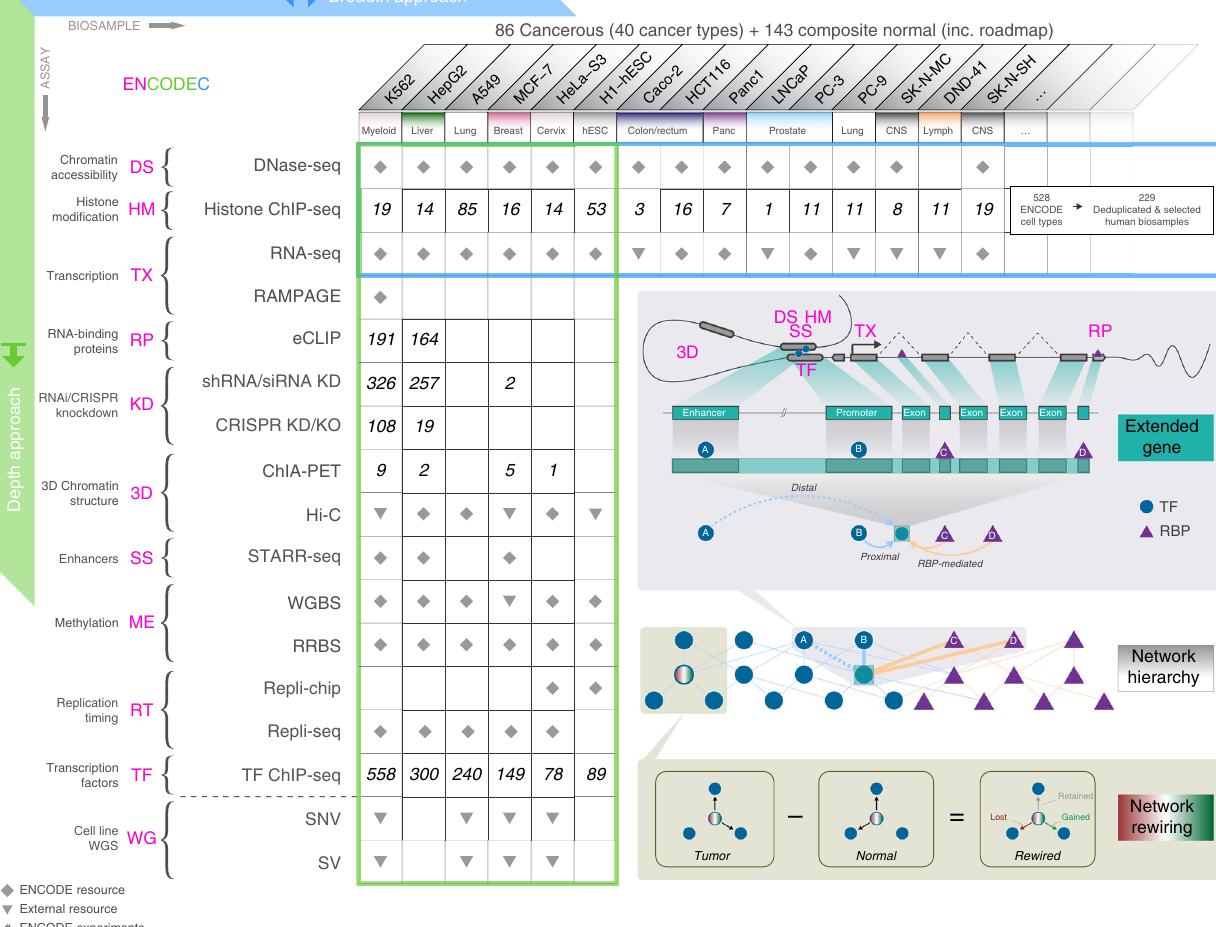
Fig. 1 Overview of the ENCODEC resource. Table columns list cell types and rows list assays. Blue table boundary: Cell types with assays in the ENCODE Encyclopedia highlight the breadth of the resource. The large number of cell types allows for comparative analyses between cell-types, as well as cell-type speci fi c analyses. Green table boundary: cell-type speci fi c analyses based on deep annotations of cell lines. The integration of assays allows for high- resolution investigation of genomic biology. Inset: we use annotations from cell-type speci fi c ENCODE assays to build extended gene de fi nitions — coding and non-coding elements that are linked according to their interaction and associated function (top). We relate transcription factors (TFs) and RNA binding proteins (RBPs) in a joint network hierarchy that describes their regulatory potential (middle). By comparing regulatory networks in tumor and normal ENCODE samples, we develop rewiring networks that may relate to regulatory changes that occur in the context of normal-to-tumor transition